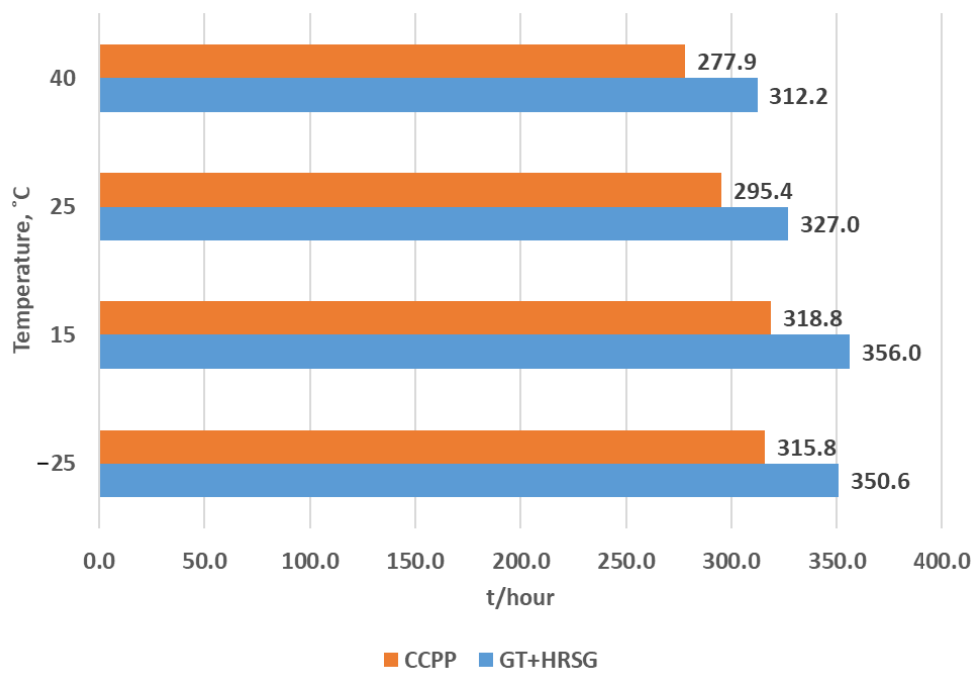
Figure 9. Dependence of steam production on ambient temperature.